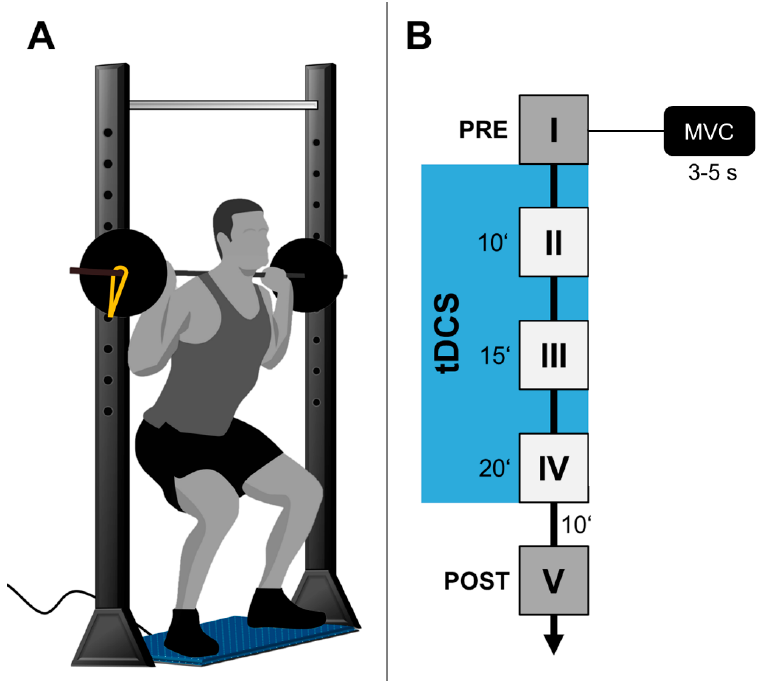
Figure 1. Study design. ( A ) Schematic representation of default positioning during isometric barbell squats (iBS) measurements. ( B ) Overview, regarding study procedures. Illustrated are all five maximum isometric voluntary contraction (MIVC) measurement blocks (I–V) alongside an exemplary depiction of a MIVC measurement conducted per one block for block I. MIVC blocks during stimulation are framed by a blue rectangle.